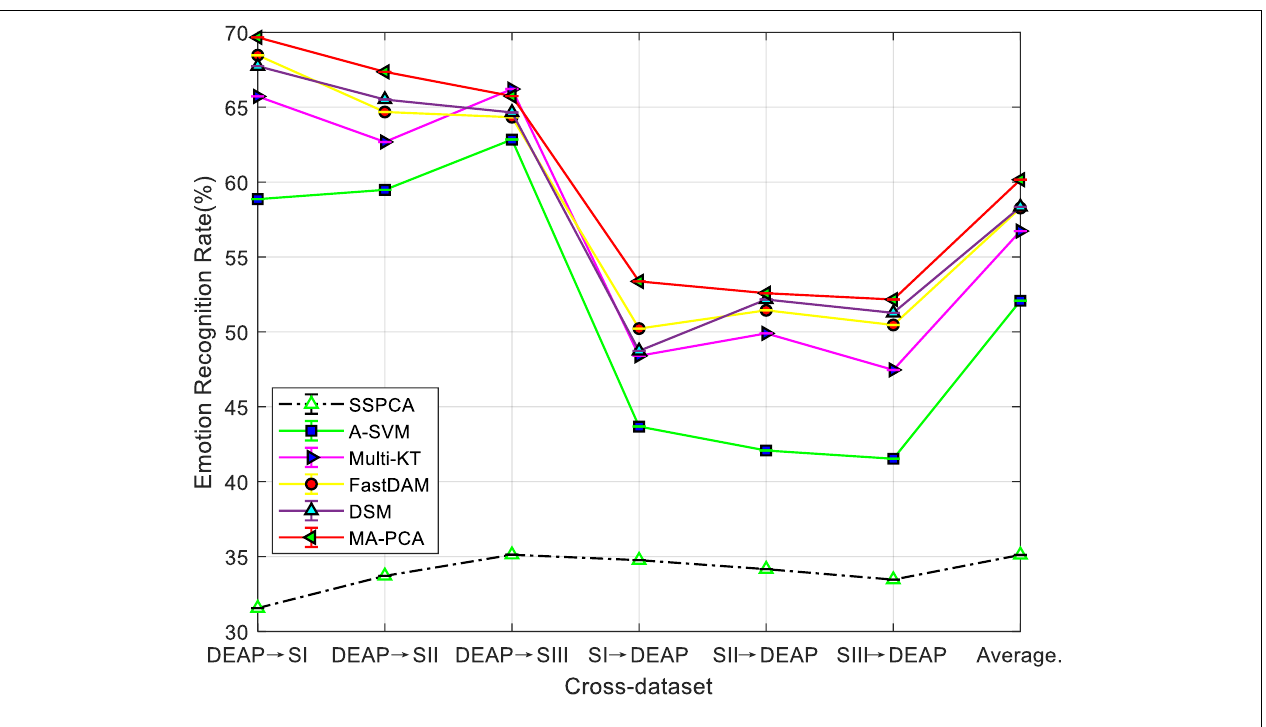
FIGURE 3 | Domain adaptation emotion recognition on